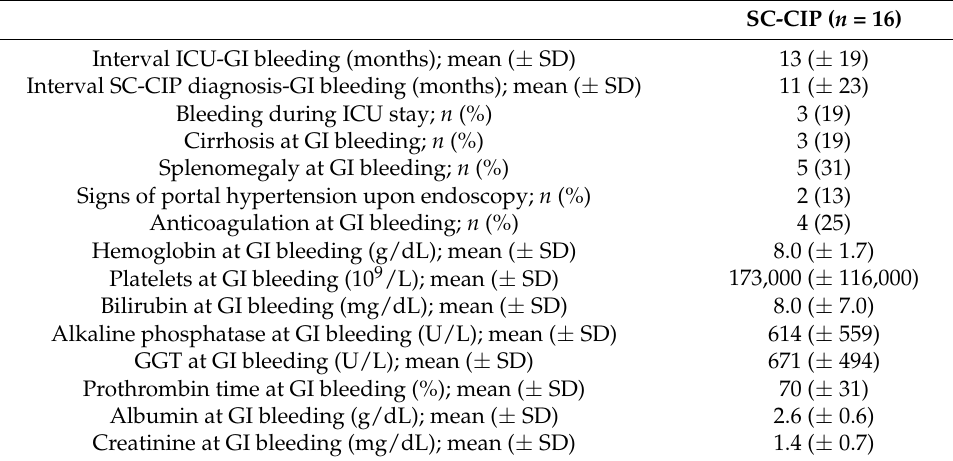
Table 3. Characteristics of patients with SC-CIP and GI bleeding.